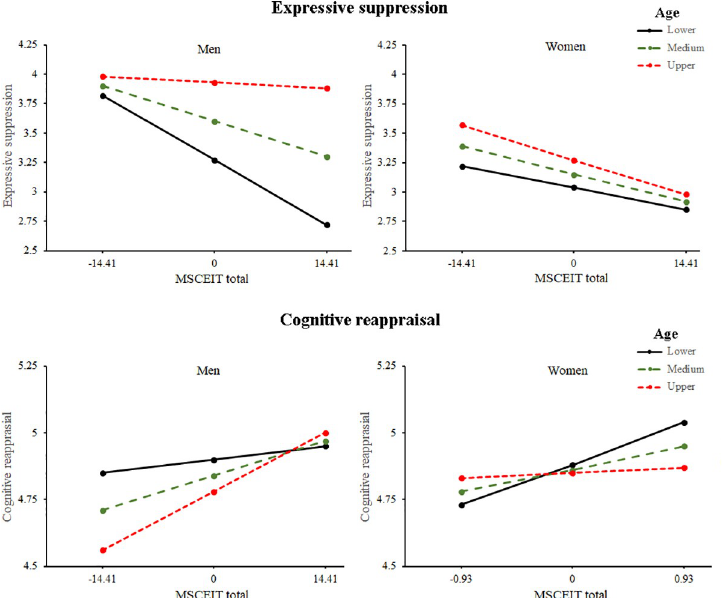
Fig 1. Top panel: moderation of gender and age on the relationship between MSCEIT total and expressive suppression (top panel) and on the relationship between MSCEIT total and cognitive reappraisal (bottom panel). Values of age, expressive suppression, and cognitive reappraisal are mean-centered